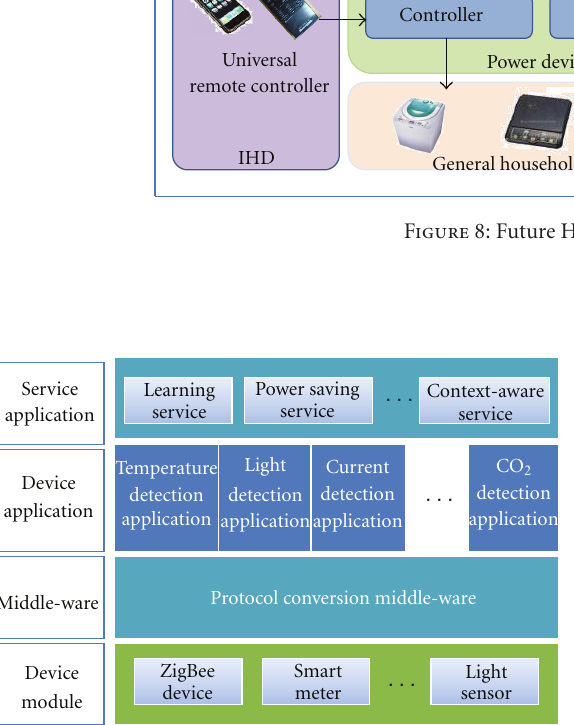
Figure 9: Software stack of intelligent power management platform